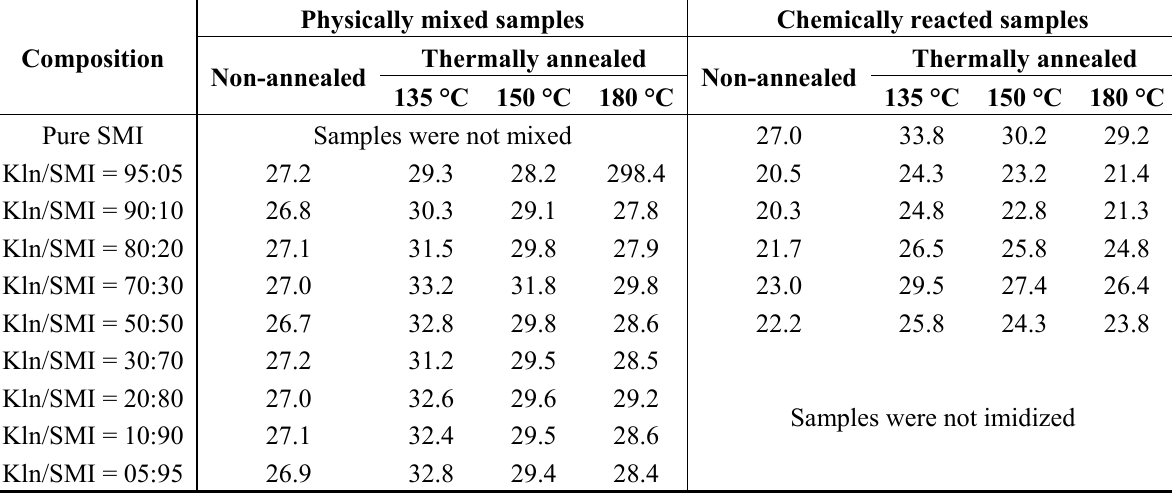
Table 3. Imide content (%) for chemically reacted and physically mixed Kln/SMI calculated from FT-Raman spectroscopy (relatively to a maximum of 35% for fully imidized SMI). Physically mixed samples Chemically reacted samples Thermally annealed Thermally annealed Composition Non-annealed Non-annealed 135 °C 150 °C 180 °C 135 °C 150 °C 180 °C Pure SMI Samples were not mixed